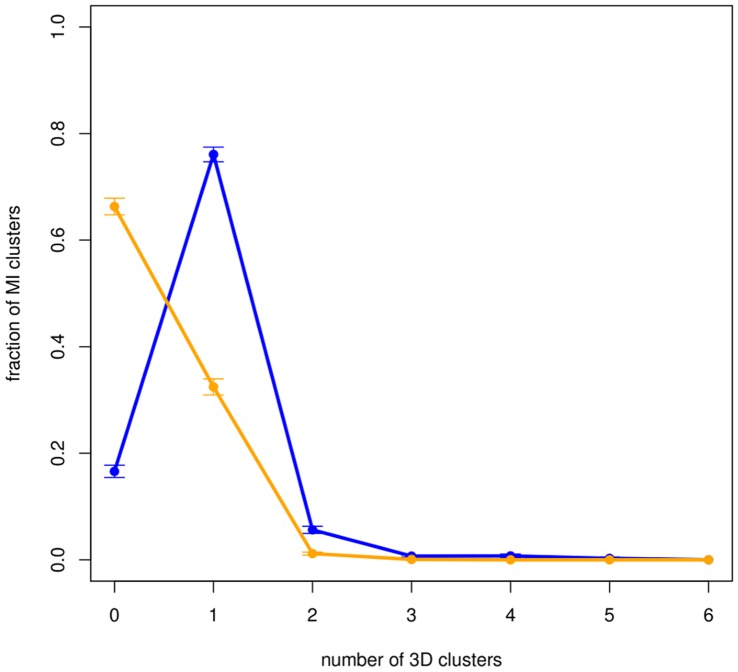
Distribution of the number of 3D clusters generated by mapping the MI cluster onto the 3D structure.Blue line: all MI3D clusters. Orange line: only catalytic MI3D clusters. 74.1% of MI clusters are preserved as a single MI3D cluster after mapping (93.1% according to random expectation). 25.9% of MI clusters produce one catalytic MI3D cluster after mapping (92.0% according to random expectation).